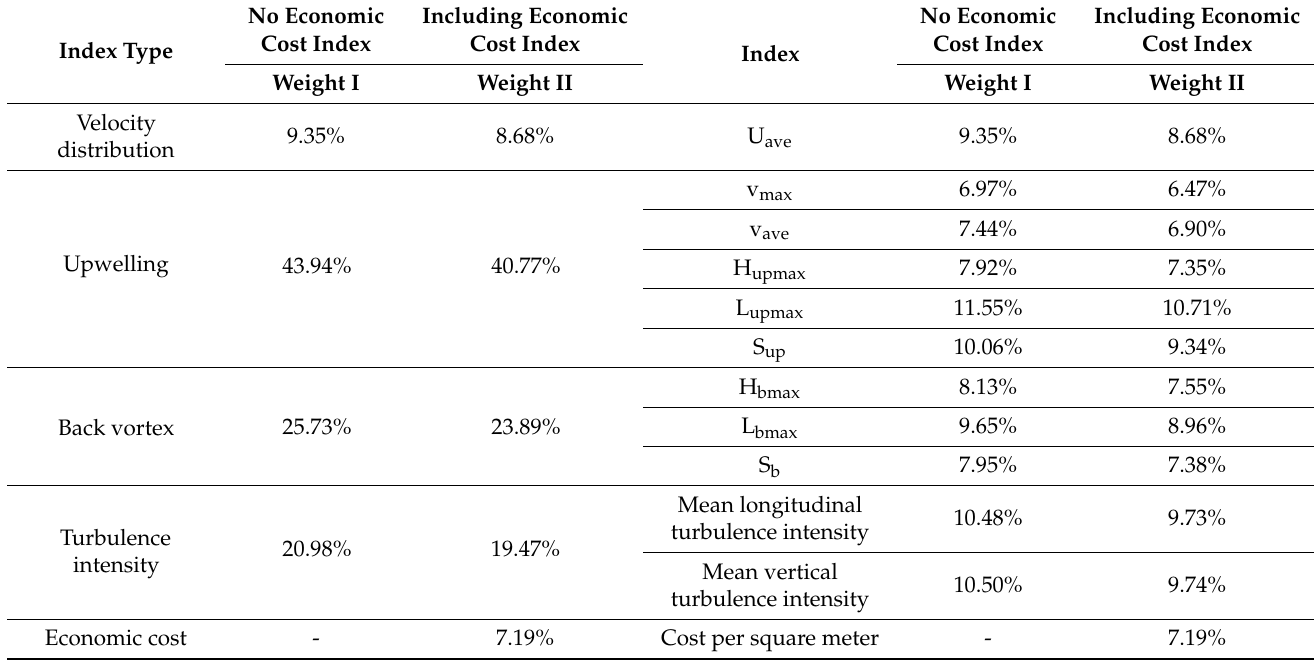
Table 4. Weight system for each variable affecting the flow field around M-shaped unit